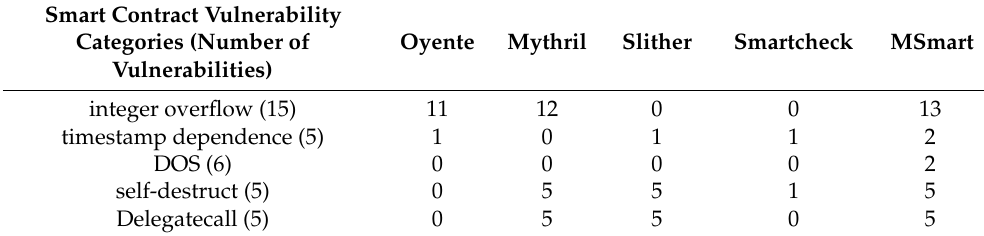
Table 5. Comparison of MSmart and other